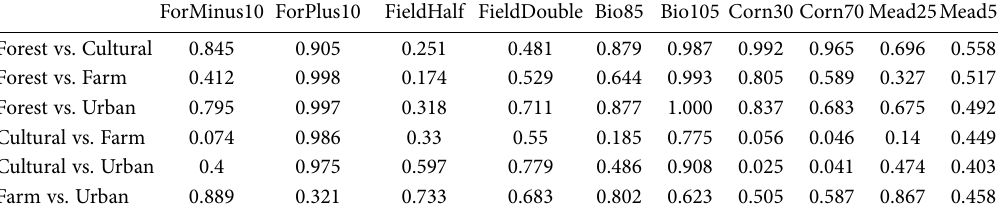
Table 10. Poe test